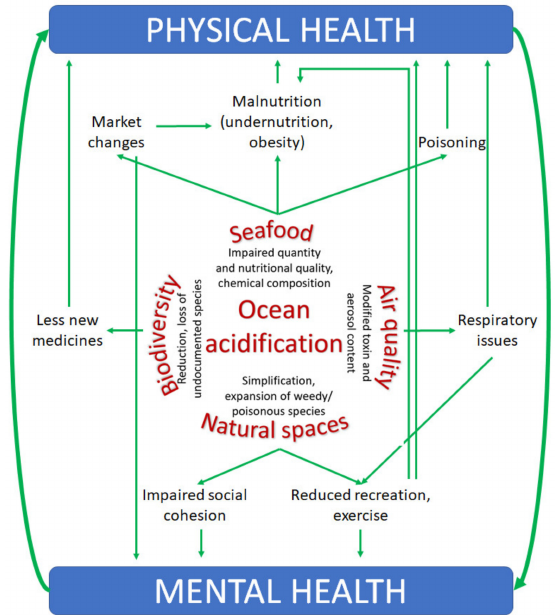
Figure 1. Ocean acidification is predicted to negatively a ff ect four of the main services provided by the ocean (seafood, air quality, natural spaces, and marine biodiversity). All of these services are linked to physical and mental health through interconnected direct and indirect